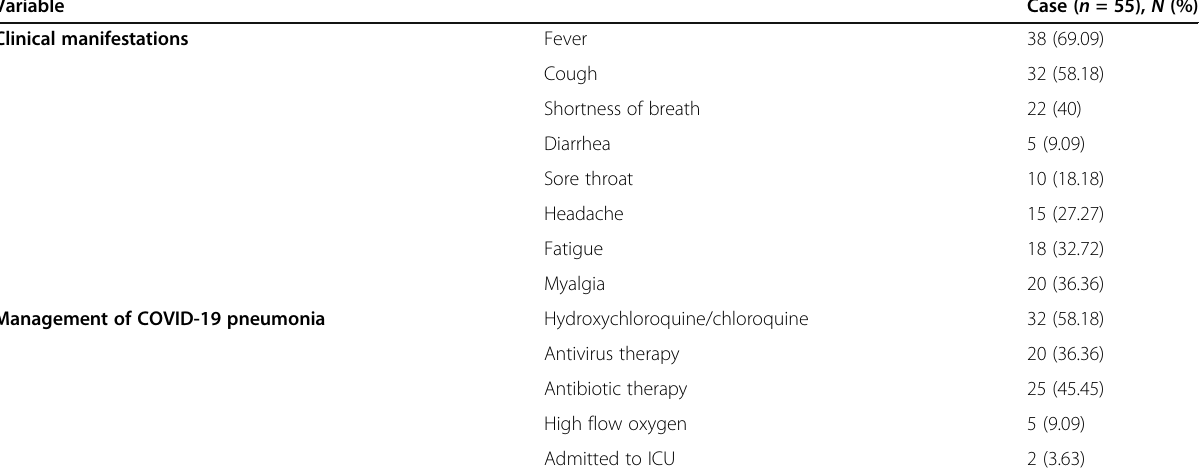
Table 3 Clinical characteristics of case group Variable